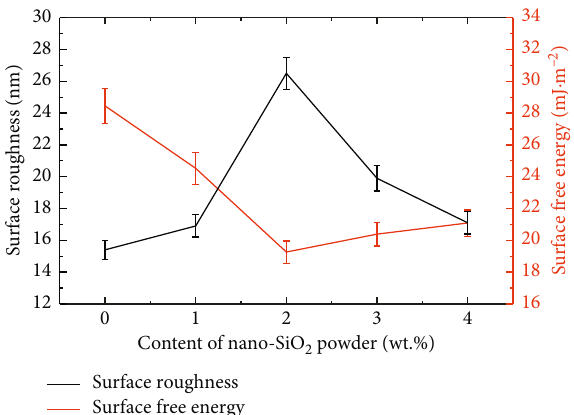
Figure 10: Antisticking force with different contents of nano-SiO